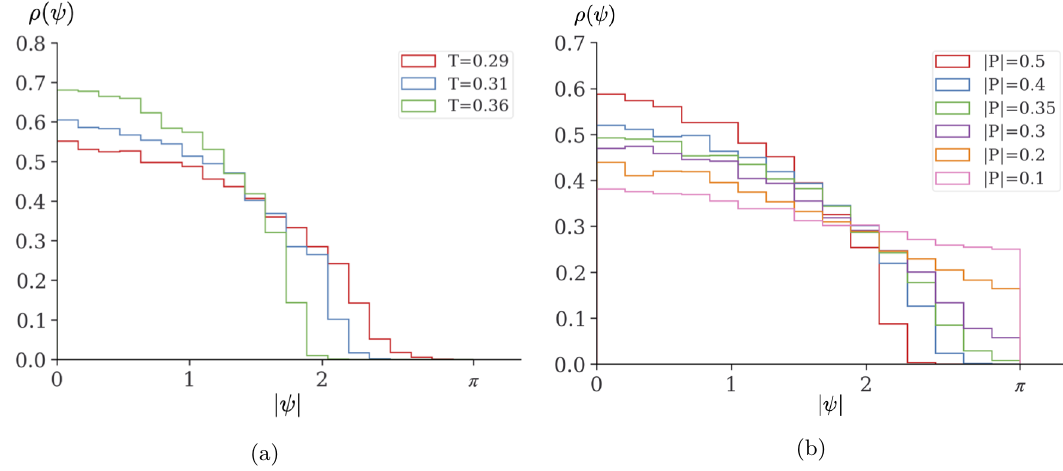
Figure 14. Numerical results for the distribution of Polyakov loop phases, ρ ( ψ ) , as a function of | ψ | , in the theory with action in eq. (3.2), for N = 32 and n t = 24 . We use | ψ | because, if the number of samples is sufficiently large, ρ ( ψ ) is symmetric about ψ = 0 . (a) The deconfined phase, as T decreases through the confinement/deconfinement transition temperature T c ’ 0 . 31 , where the free energies of confined and deconfined phases coincide. We see a gap at ψ = π that shrinks as T decreases, as expected. (b) Fixed- P simulations at the lowest T in the deconfined phase, T = 0 . 29 , i.e. near the GWW transition. Specifically, we fixed P with δ = 5 × 10 − 3 in eq. (3.4), with 400 configurations for each P . We see that as P decreases, the gap closes at P ’ 0 . 35 , so we identify P ≤ 0 . 35 as the partial